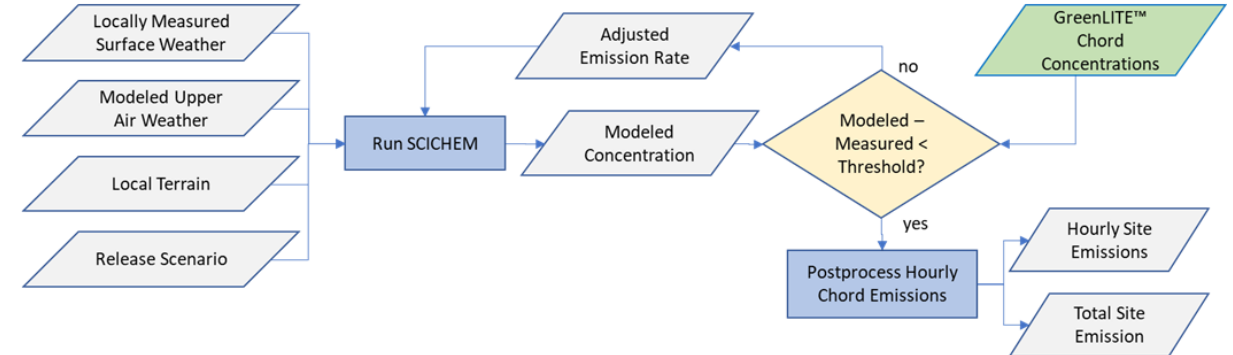
Figure 3. Emission estimation flow